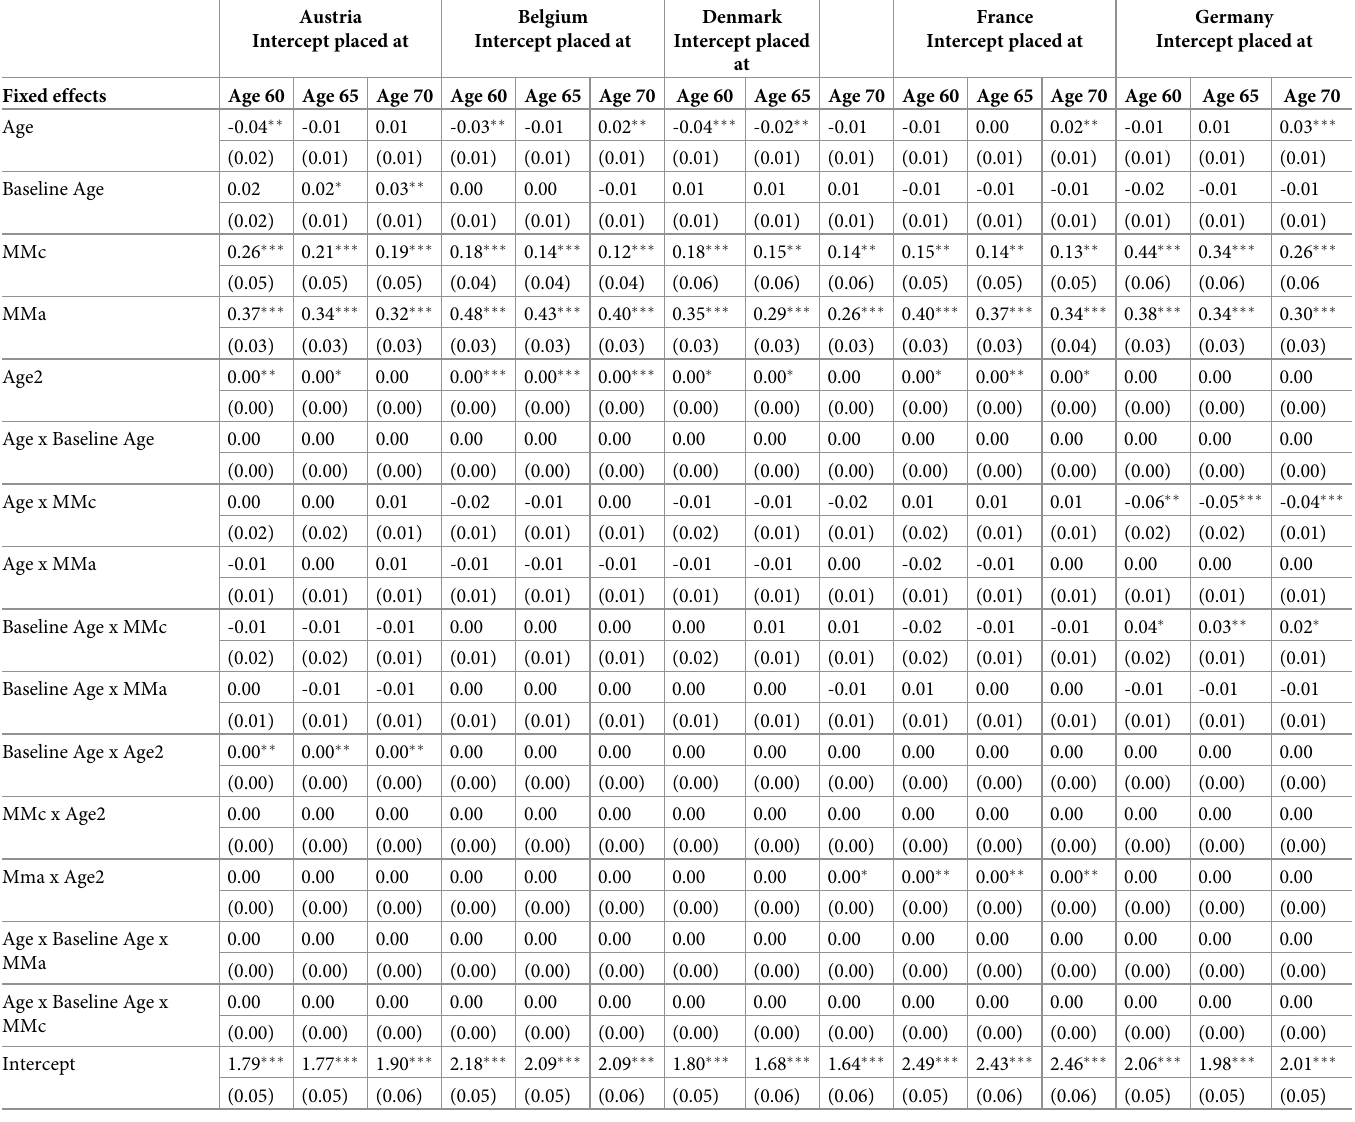
Table 2. Fixed effects estimates for